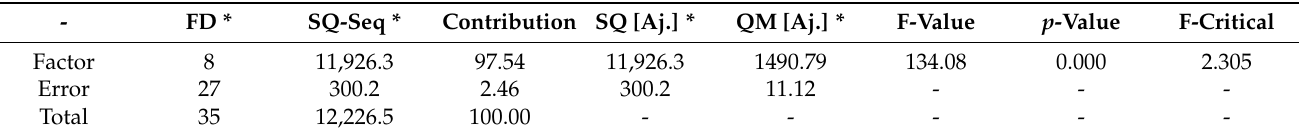
Table 7. ANOVA applied to the percentages of each MHSW fraction material in relation to the total mass of the sample for the gravimetric analysis of